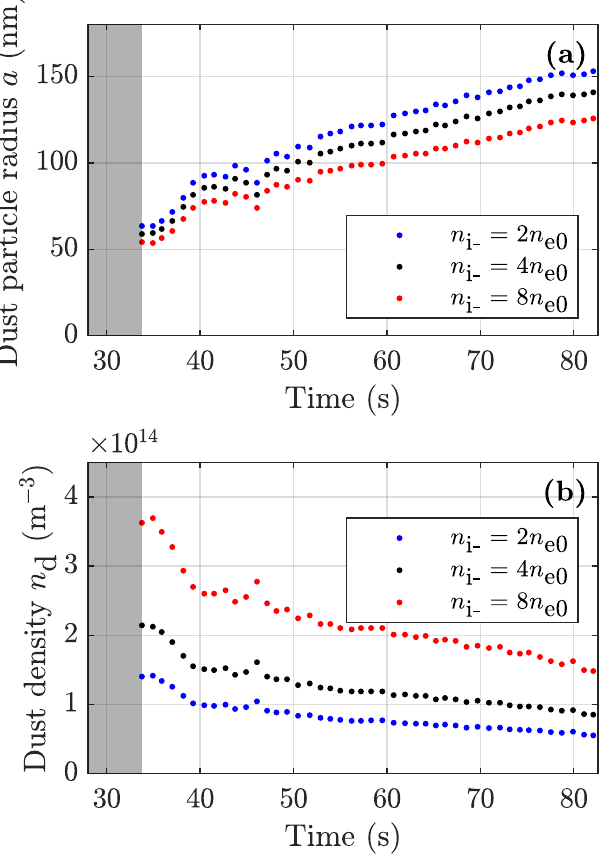
Figure 7. Sensitivity analysis for the negative ion density. Using the same raw data set, the dust particle radius (shown in panel ( a )) and dust density (shown in panel ( b )) are determined for negative ion densities ranging between n i − = 2–8 n e,initial , while a constant value of the electron temperature T e = 3eV is